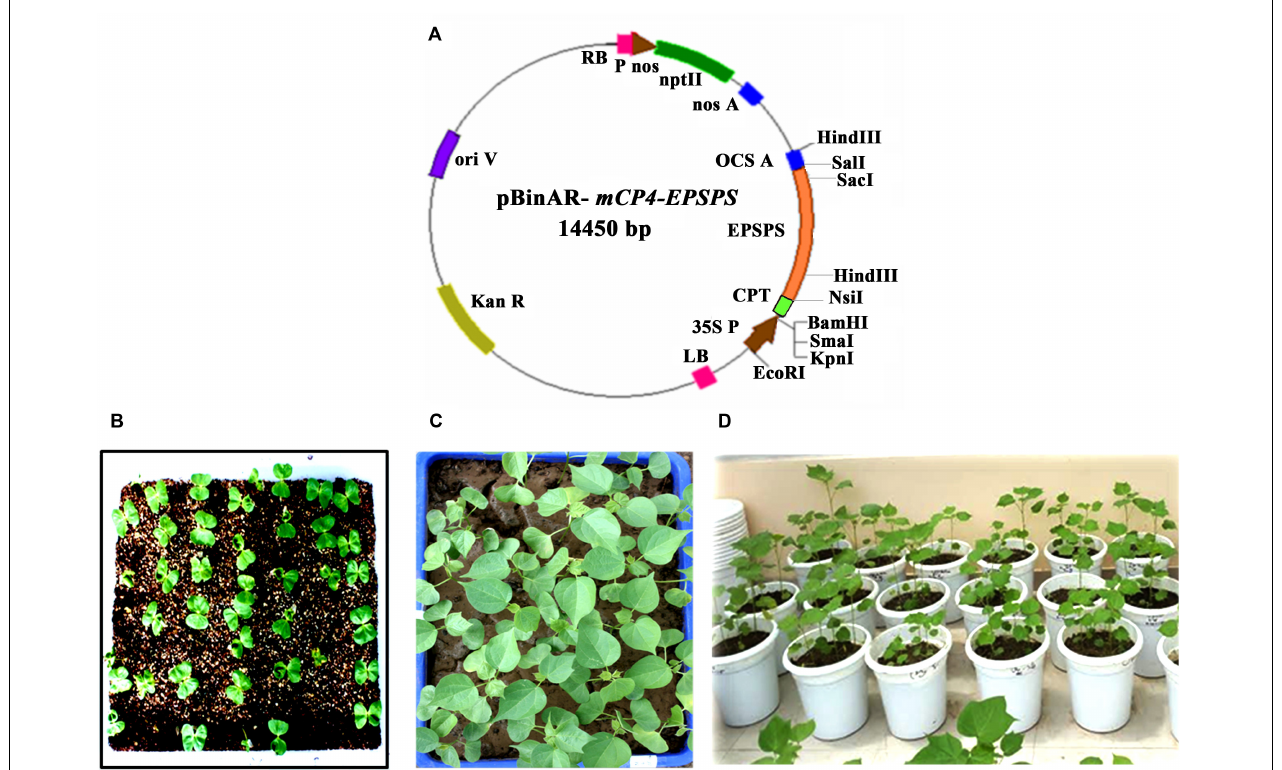
FIGURE 1 | Agrobacterium tumefaciencs –mediated in planta transformation in cotton. (A) Vector map of pBinAR/EPSPS used in the study. Codon-optimized and modified CP4-EPSPS gene (1,561 bp) was assembled with varying GC content for plant codon usage and fused at the N-terminal (1–216 bp) with Petunia hybrida chloroplast targeting signal peptide (CPT). (B–D) Various stages of recovery and establishment of the primary transformants in the